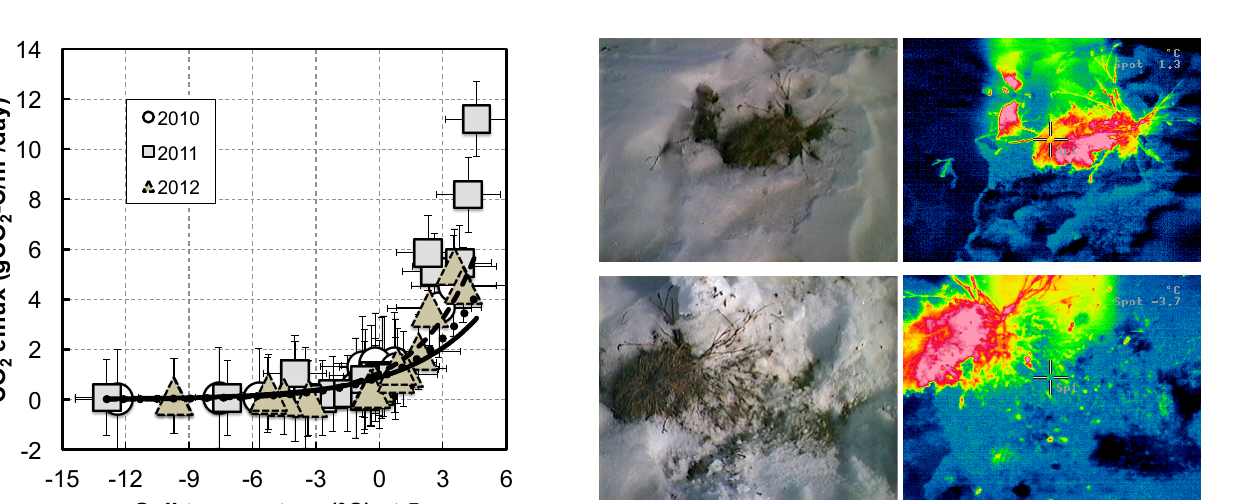
covered and snow-melting seasons of 2011 and 2012. Three- year average spring CO 2 efflux depends on soil temperature at 5 cm below the surface, explaining 45 % of the variability of spring CO 2 efflux in tundra